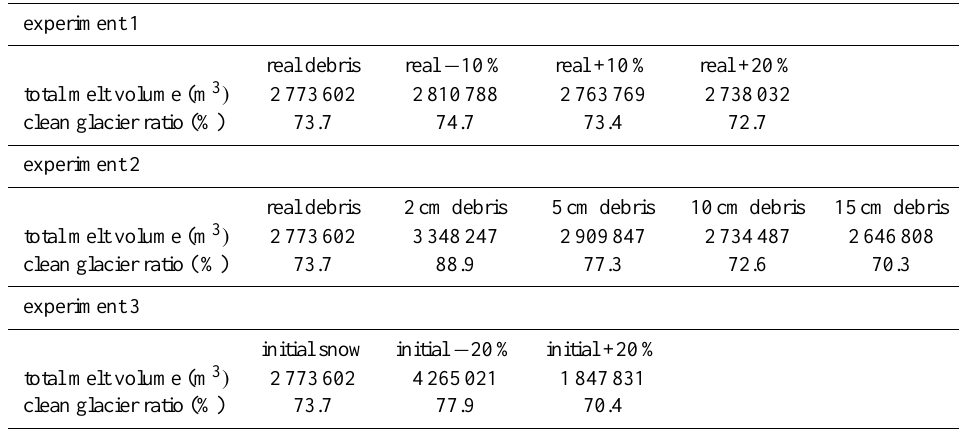
Table 3. Results from sensitivity experiments of the ablation model for the Adyl-su basin. In experiment 1 the natural debris thickness distribution is varied across the glacier. For experiment 2 the natural debris cover is used, but the thickness is set to constant values. In experiment 3 the winter snow cover is changed by ± 20%. In addition to the resulting melt volume also the relation to the ablation for a debris free glacier is presented.